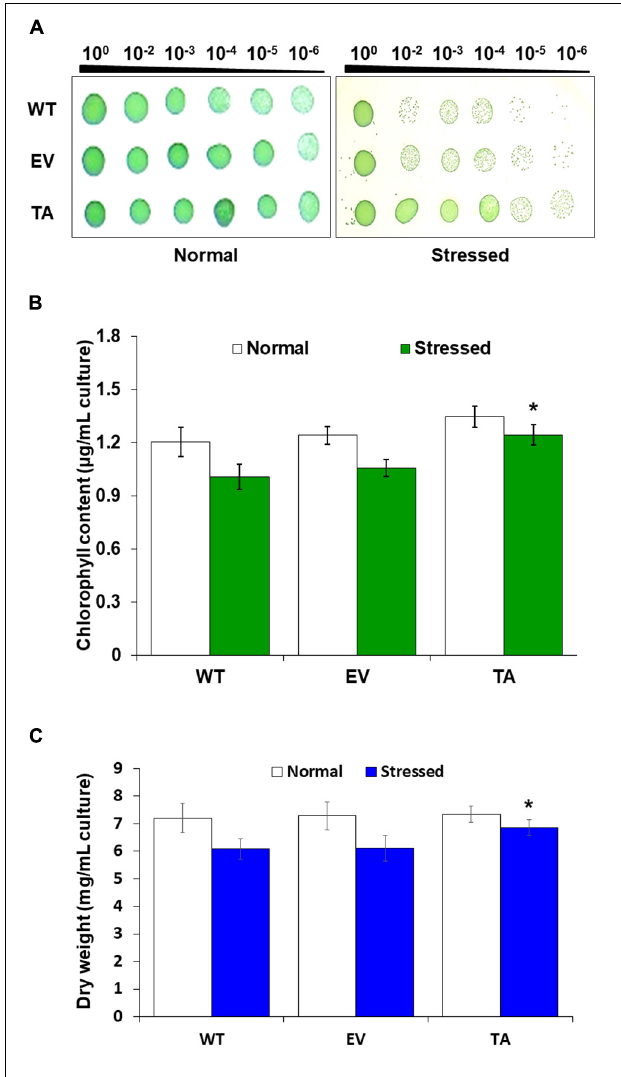
FIGURE 3 | Stress sensitivity in the OsDHAR -expressing transgenic TA. (A) Cell viability was evaluated based on number of colony-forming units and spotting assay. (B) Chlorophyll contents of grown for 2 days in the presence of 2.5 mM H 2 O 2 ( A 730 = 0.3). (C) Dry weights measured at 7 and 9 days after growth in the presence or absence of 2.5 mM H 2 O 2 for 2 days. Error bars indicate ± SD of biologically least three independent experiments. Asterisks indicate significant differences between treatments as estimated by Student’s t -test ( P < 0.05). WT, WT S. elongatus PCC 7942; EV, empty